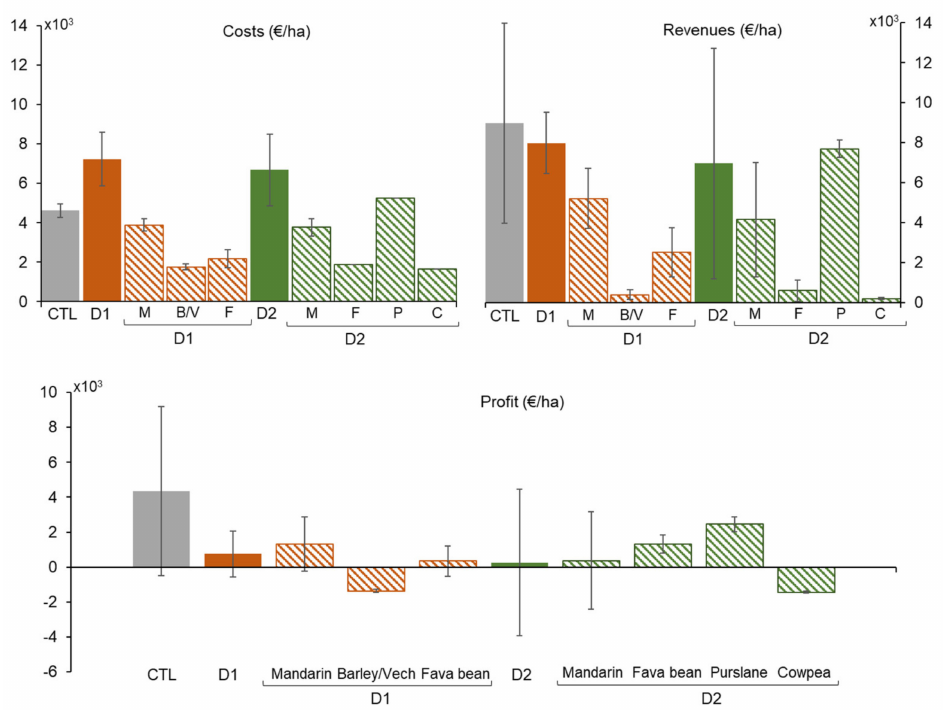
Figure 4. Mean value and standard deviation of the annual costs, revenues, and profit per unit of area. The bars with solid patterns show the total values per hectare of cultivated area for mandarin (CTL), diversification D1 (D1), and diversification D2 (D2). The bars with diagonal line patterns correspond to the disaggregated values for each crop in D1 and D2.